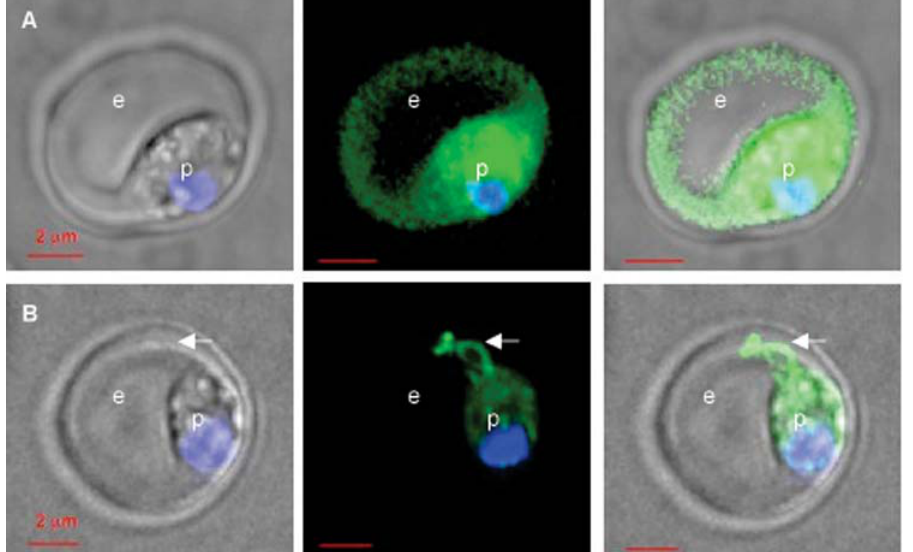
Figure 3. The HT motif of P.falciparum HRPII is recognized in P.berghei ANKA and transported to the erythrocyte cytoplasm. Export of the HT-containing N terminus of HRPII, a secretome protein specific to P. falciparum , depends on a functional HT motif when expressed in P. berghei . Live cell images of ( A ) HRPIIminhis.HT.GFP and ( B ) HRPIIminhis. D .GFP expression in P. berghei- infected erythrocytes isolated from infected mice. White arrow indicates tubovesicular structures extending from the PV to the periphery of the erythrocyte. e , erythrocyte, p ,